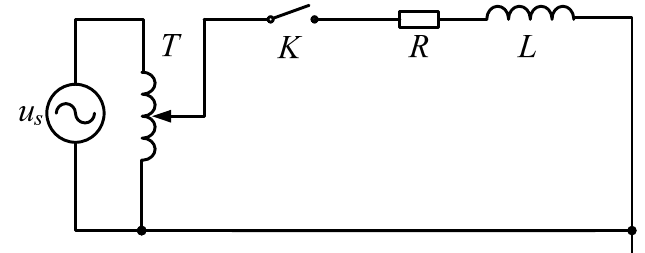
Figure 8. Experimental circuit diagram.